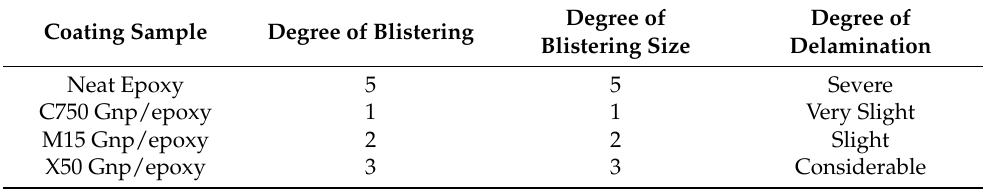
Figure 8. Optical images of neat epoxy and GNPs/epoxy coatings under salt spray testing against immersion time. Table 4. Ranking of coating failure after 800 h of salt spray testing according to ISO 4628–2